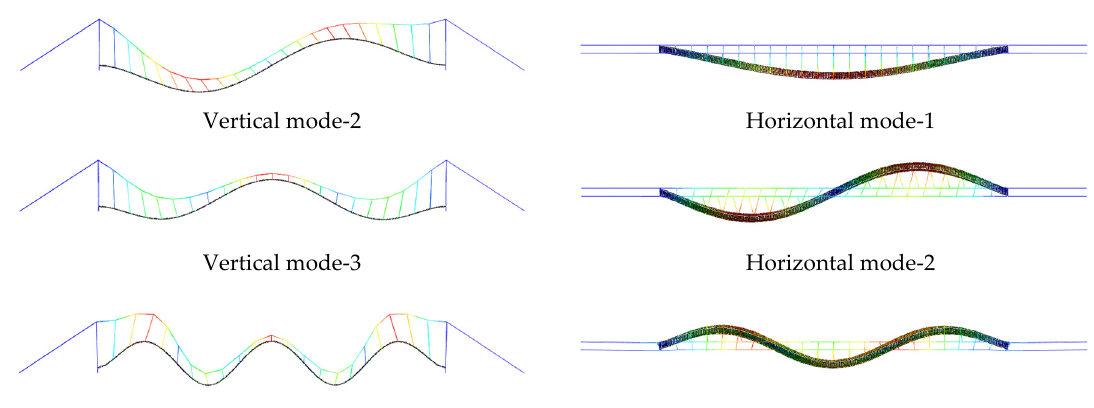
Figure 12. Updated FE model dynamic mode shapes. Table 2. Model updating results to represent the real bridge.